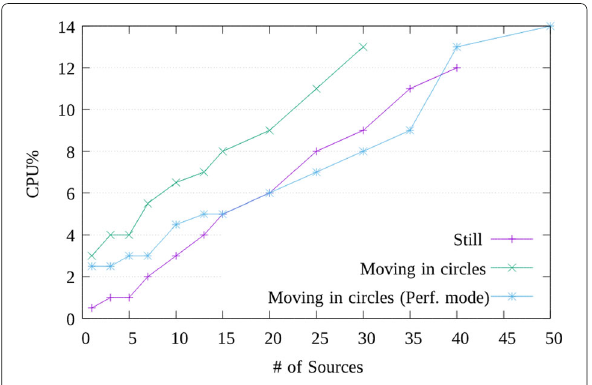
Fig. 6 Soundscape Experience Web CPU usage